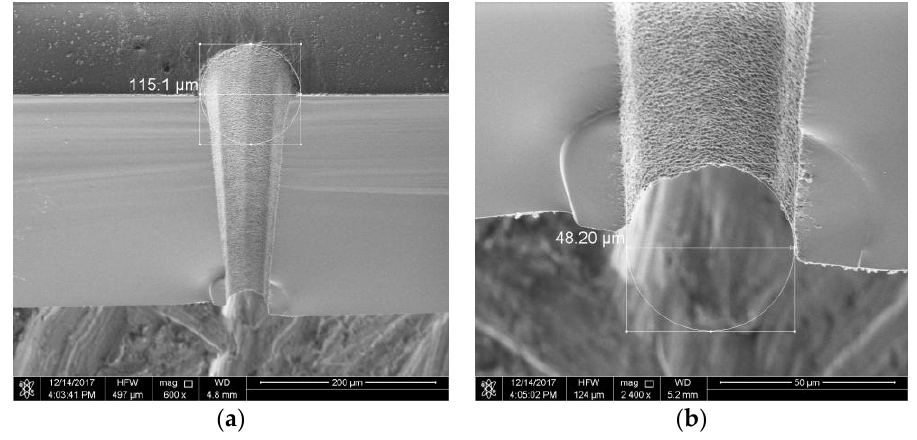
Figure 6. SEM cross-section picture of a via hole on 500-μm Pyrex 7740: ( a ) inlet; and ( b ) outlet.